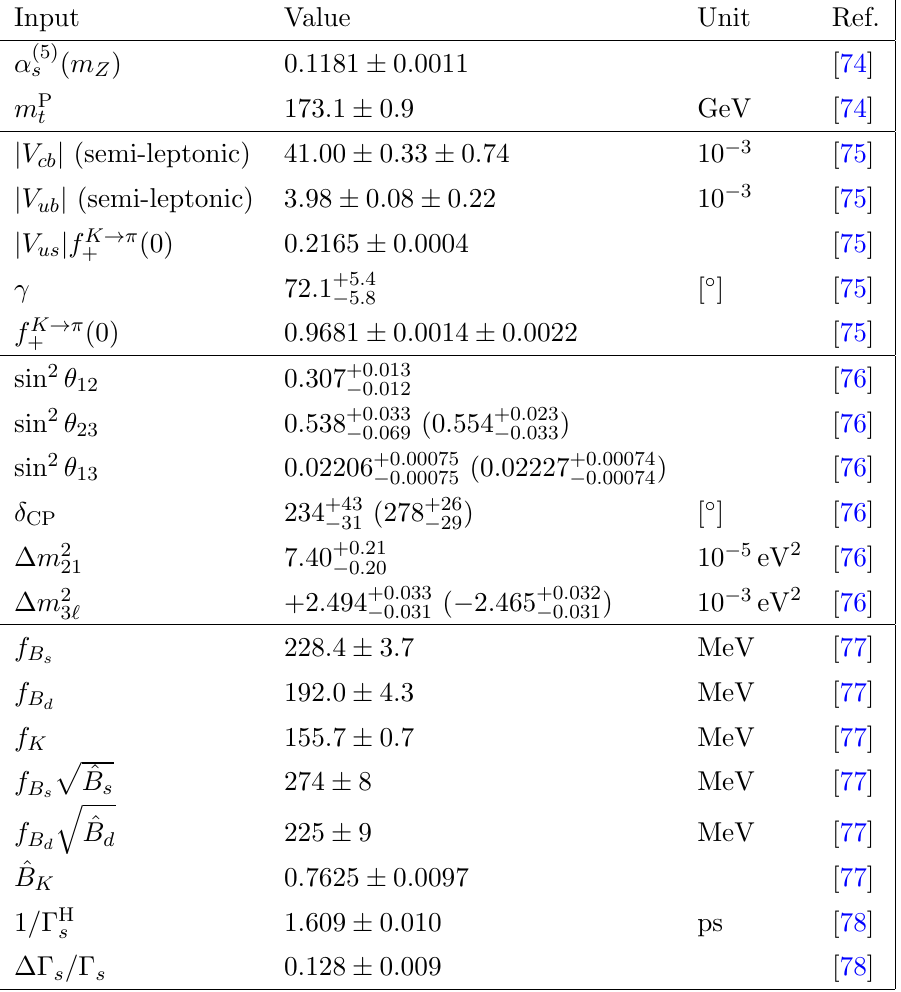
Table 1 . Input parameters used in the numerical analysis. The neutrino oscillation parameters (values in brackets) correspond to the normal (inverted) ordering of the light neutrinos’